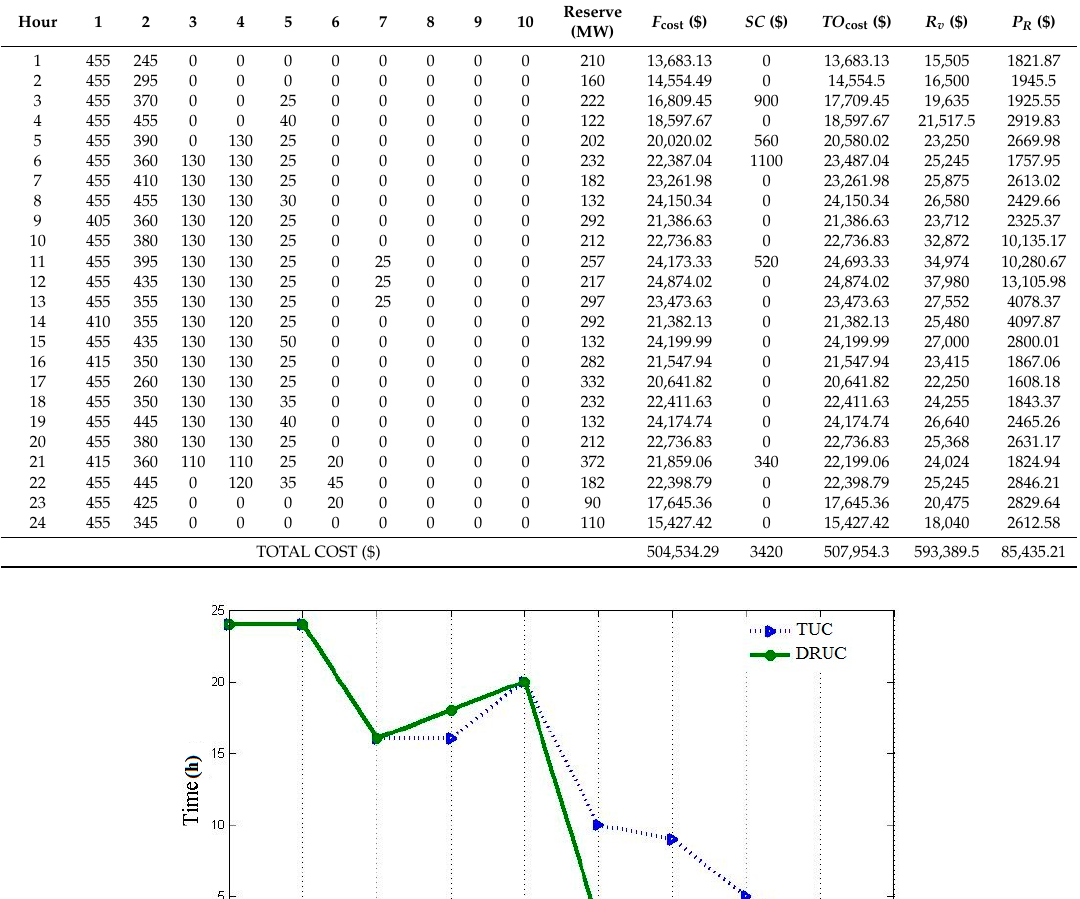
Table 7. Output data for base case established with Demand Response (DR) using Demand Response Unit Commitment (DRUC).